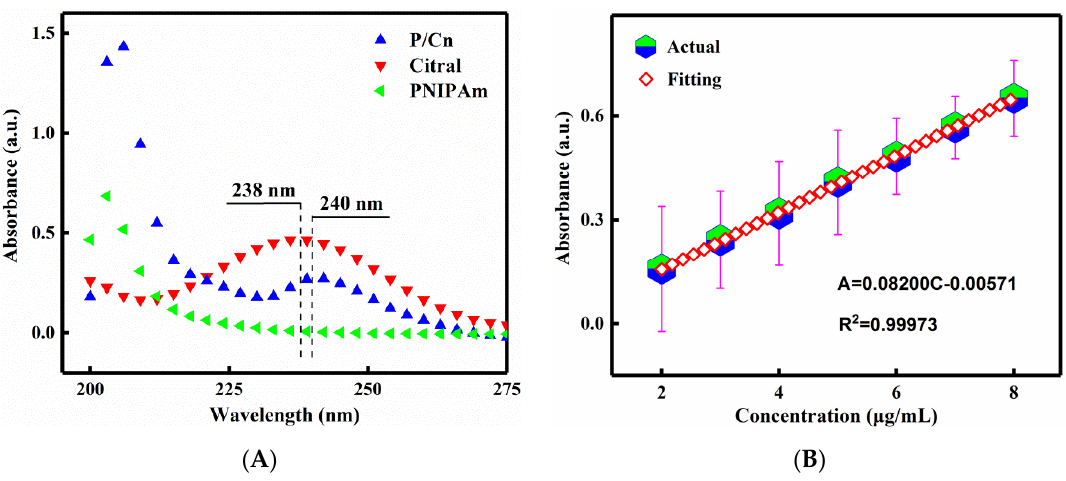
Figure 2. The Uv-vis spectra ( A ) and the standard curves ( B ) of P/Cn in PBS.